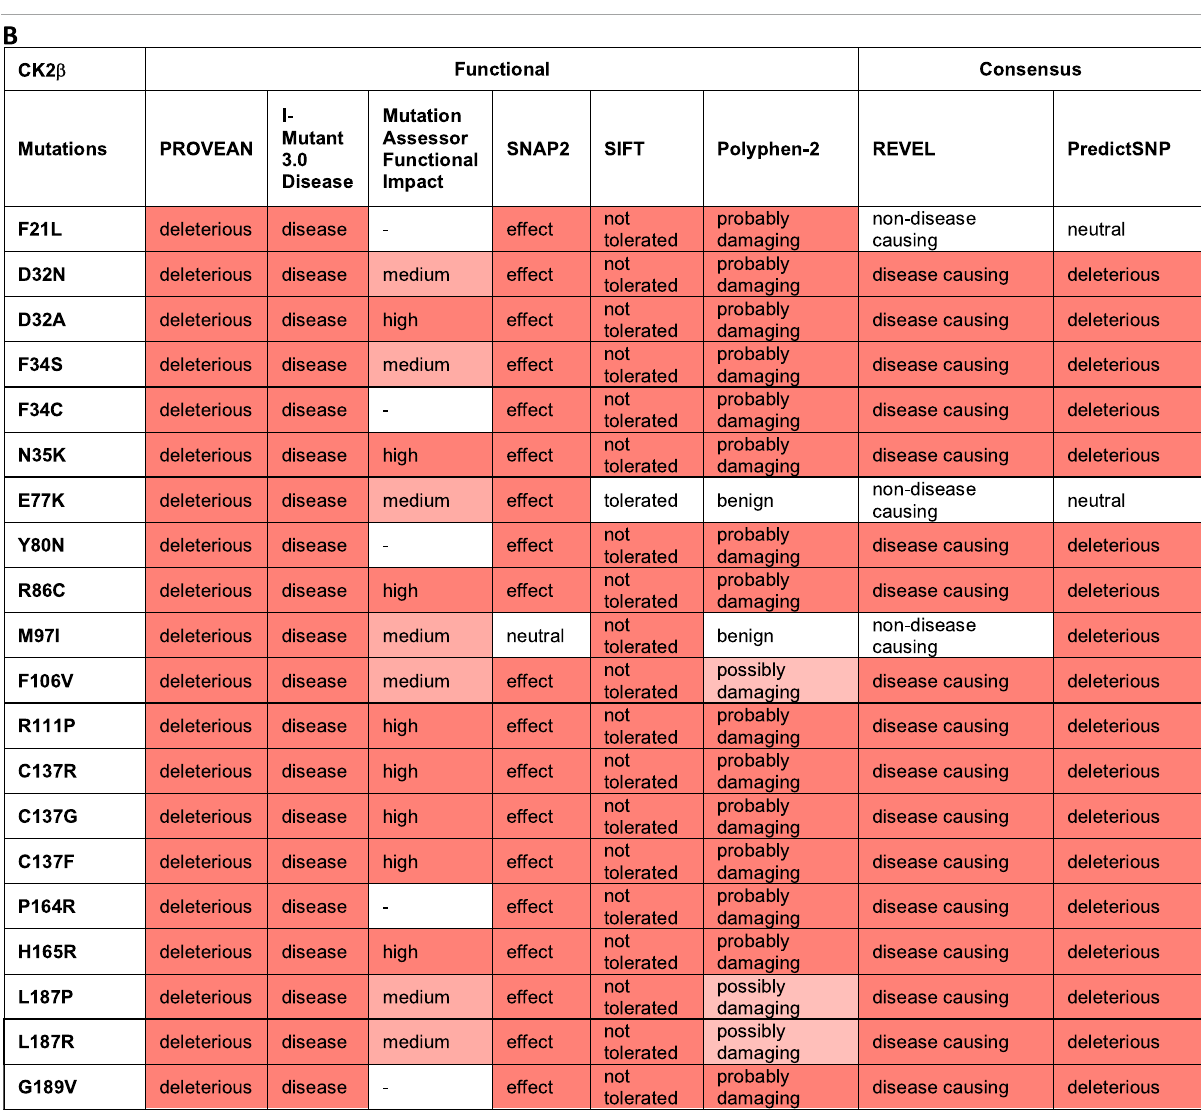
TABLE5AnalysisofCK2 α andCK2 β proteinmutations usingfunctionalpredictionprograms. PredictionsforCK2 α (A)and(B)CK2 β .Colorsinthecells re fl ect the effect from neutral (white) to high effect (red). The numbers obtained in the analysis can be found in Supplementary Table S4. (C, D) Comparison between CK2 α predictions and experimental data on CK2 α from Dominguez et al., 2021. (C) kinase activity of the recombinant CK2 α protein mutants puri fi ed from bacteria; from 0%to 25% (top rows) to 25% – 50% (bottom rows) compared to wild-type puri fi ed protein. (D)Degreeof similarity between nuclear/cytoplasmic localization CK2 α protein mutants to wild-type proteins expressed in cell lines; from low to high. N/A (= not applicable) indicates residues that could not generate a prediction. [Note: MutationAssessor has been down precluding us from analyzing 7 mutants, indicated with ( —